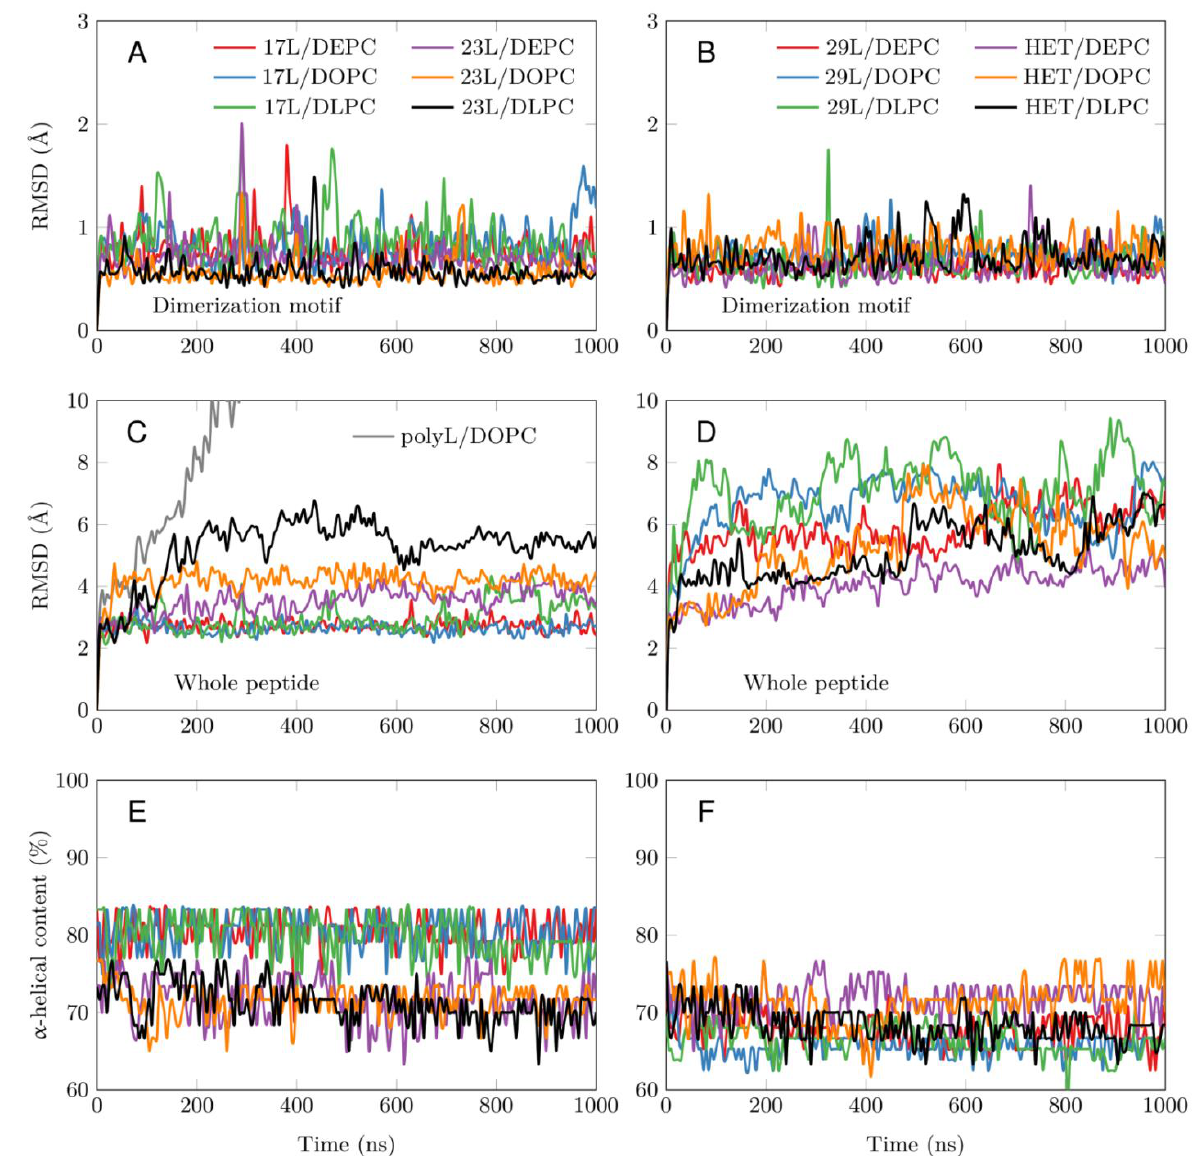
FIGURE 3: Stability of the dimeric structures from MD simulations. (A-D) Root mean squared deviation (RMSD) of the dimerization motif (5 residues per peptide) is shown on the top row and the RMSD of the whole dimer on the bottom row. The whole trajectory is included in the analyses. The 17L/29L hetero-dimer is labeled “HET”, and the polyleucine control in DOPC as “PolyL/DOPC”. (E and F) Helicity of the peptides during the full simu- lation time period (color code as in At to D). The 17L/29L hetero-dimer is labeled